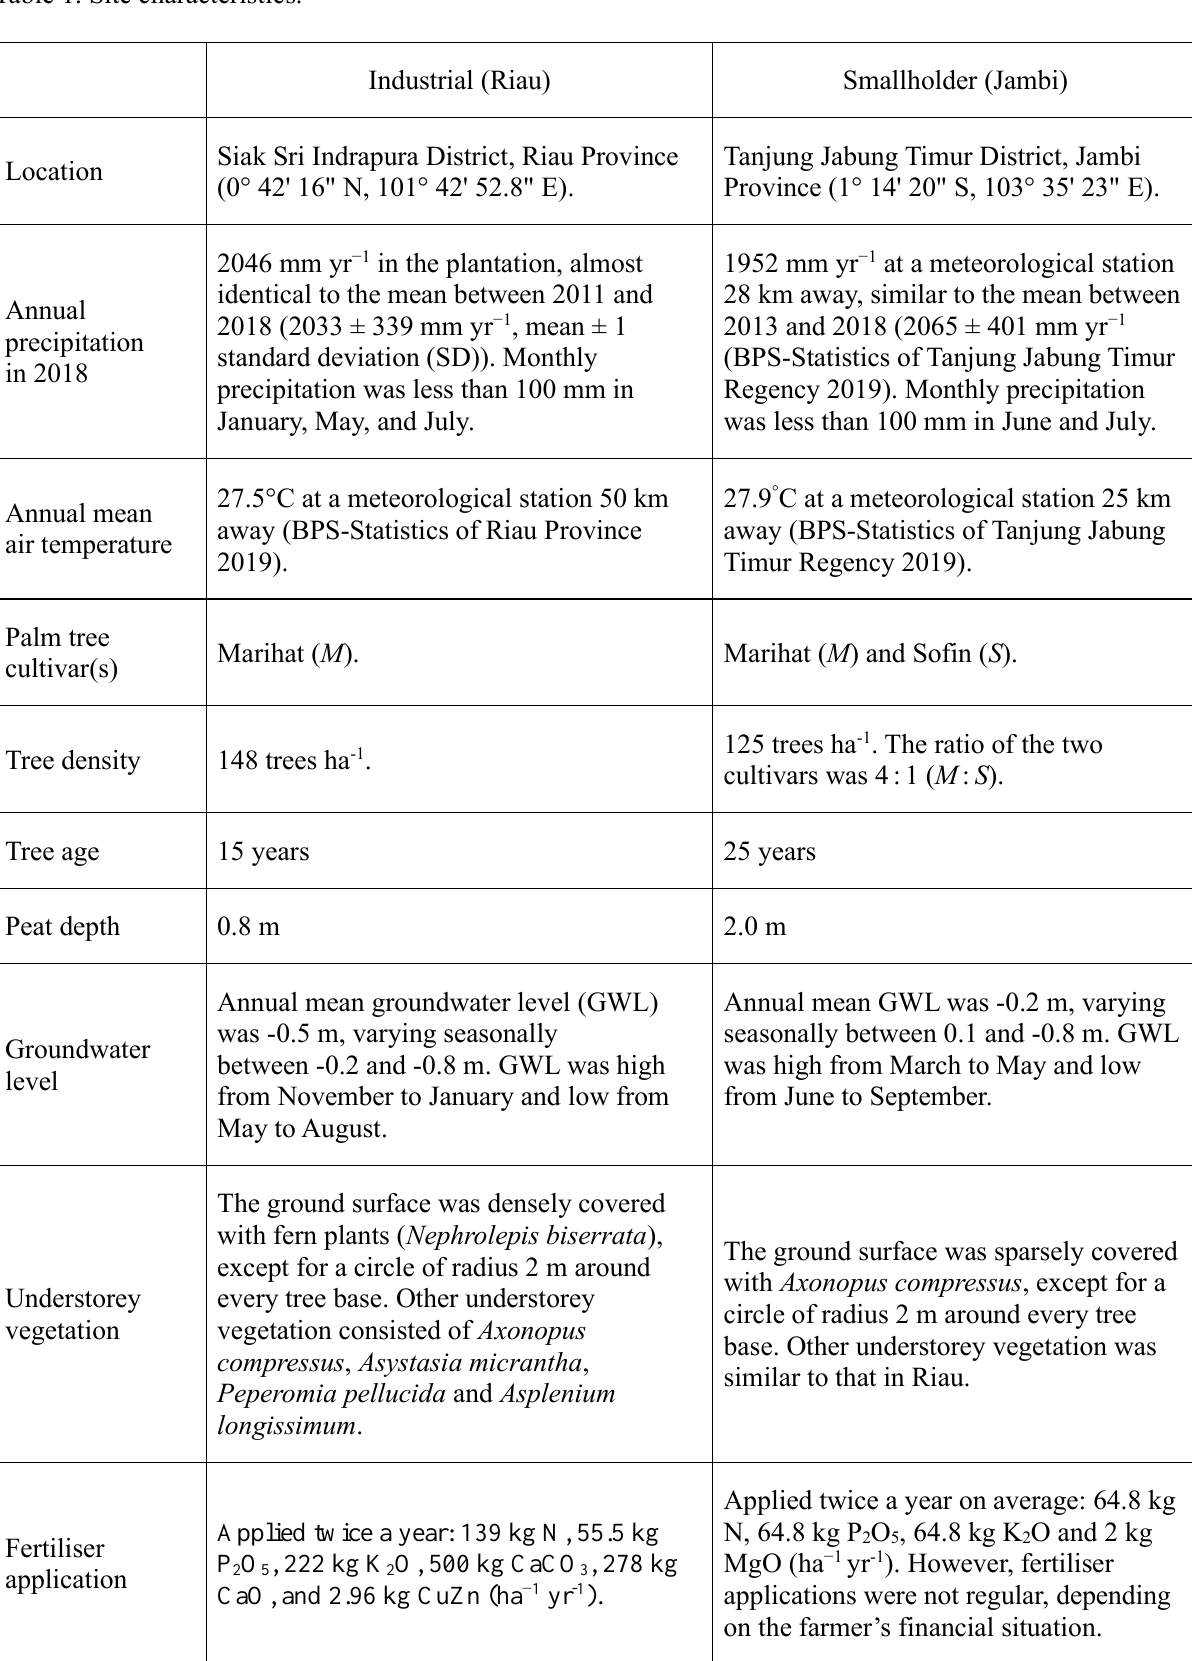
Table 1. Site characteristics. Industrial (Riau) Smallholder